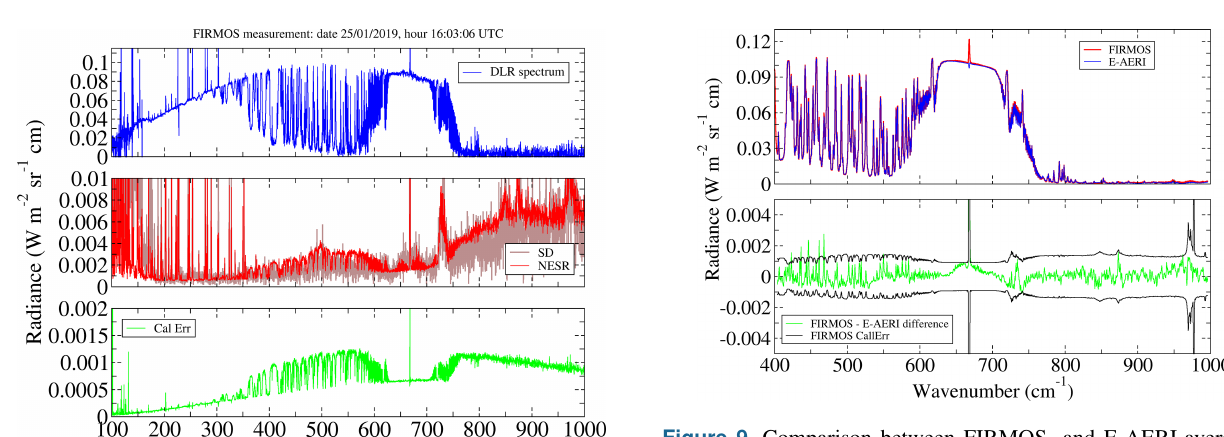
Figure 9. Comparison between FIRMOS- and E-AERI-averaged spectra of 420 simultaneous acquisitions for the 2019 campaign. Spectra were apodised with the Norton–Beer strong function with FWHM = 0.968cm − 1 and resampled to a common spectral grid of 0.5cm − 1 . The bottom graph shows the difference between the av- erage spectra (in green) compared with the total measurement un- certainty (in